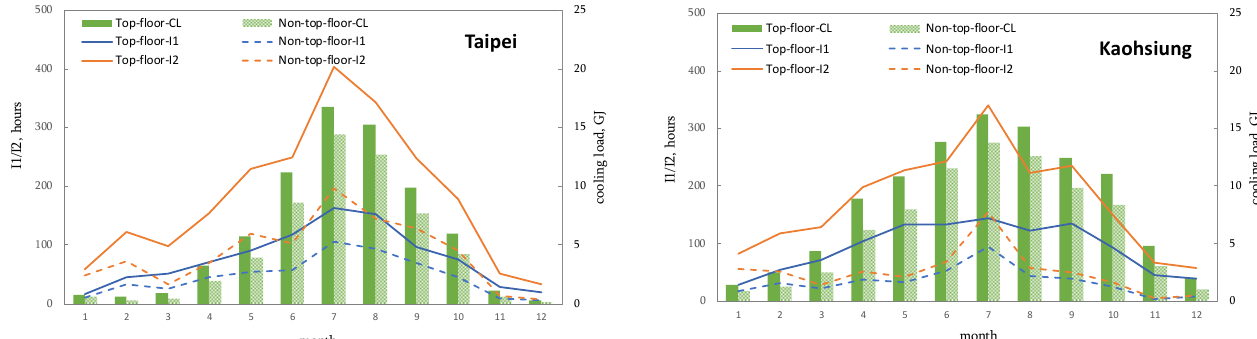
Figure 5. Comparison of cooling load, overheating hours, and weighted overheating hours between top-floor and non-top floor classrooms.